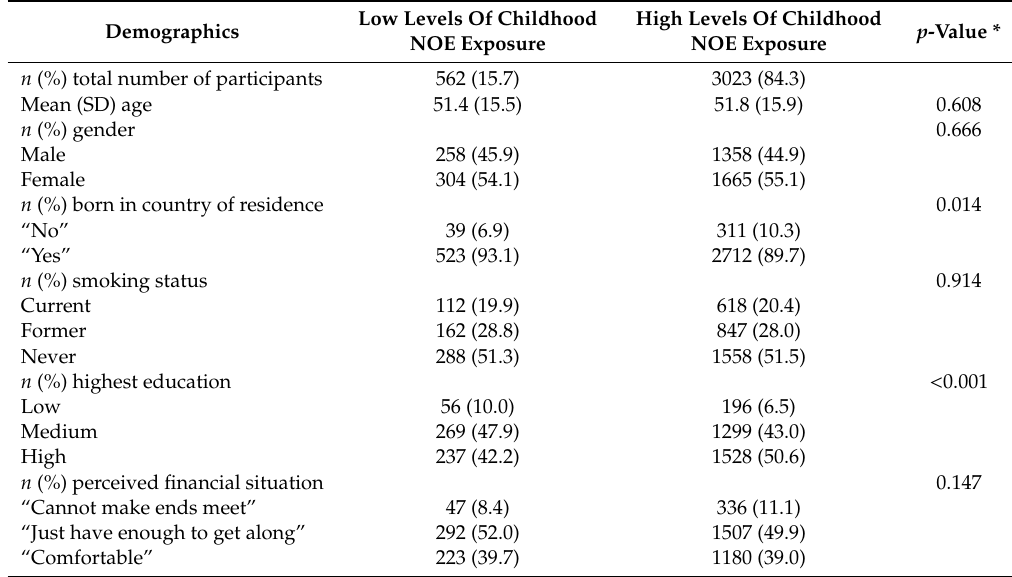
Table 4. Demographics of the study population on pooled level for subgroups with di ff erent amount of childhood NOE exposure (low levels and high levels).